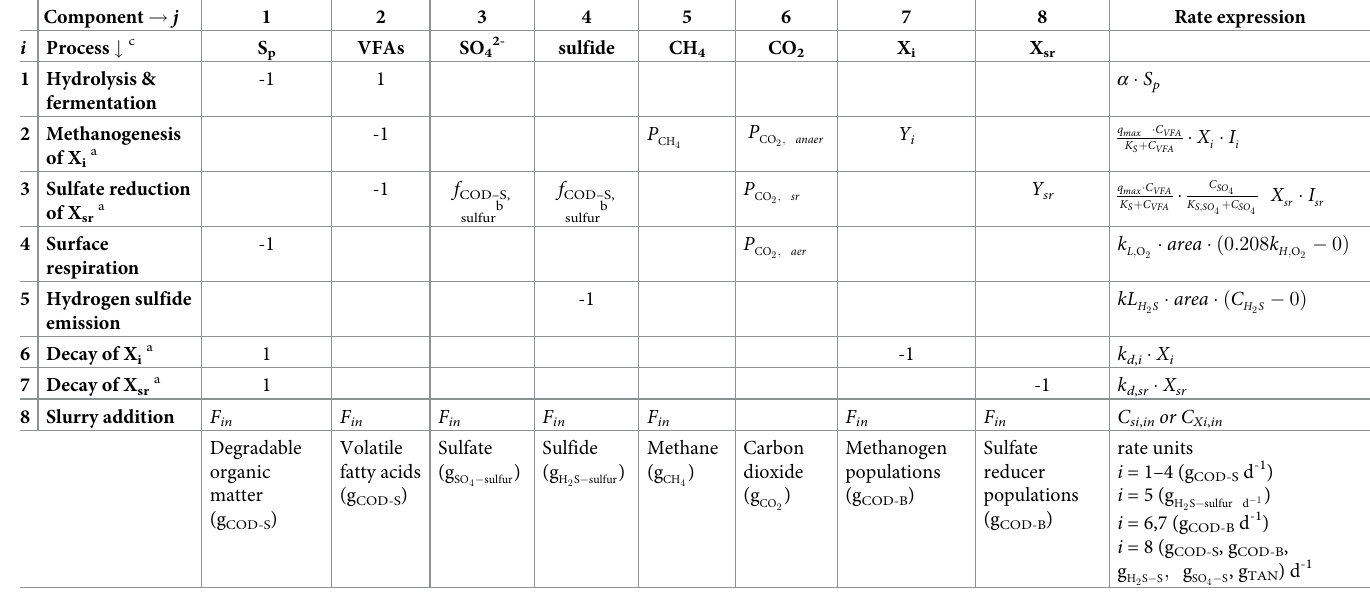
Table 1. Petersen matrix of model state variables (following [61], based on [62]). See S3 Appendix for parameter descriptions and default